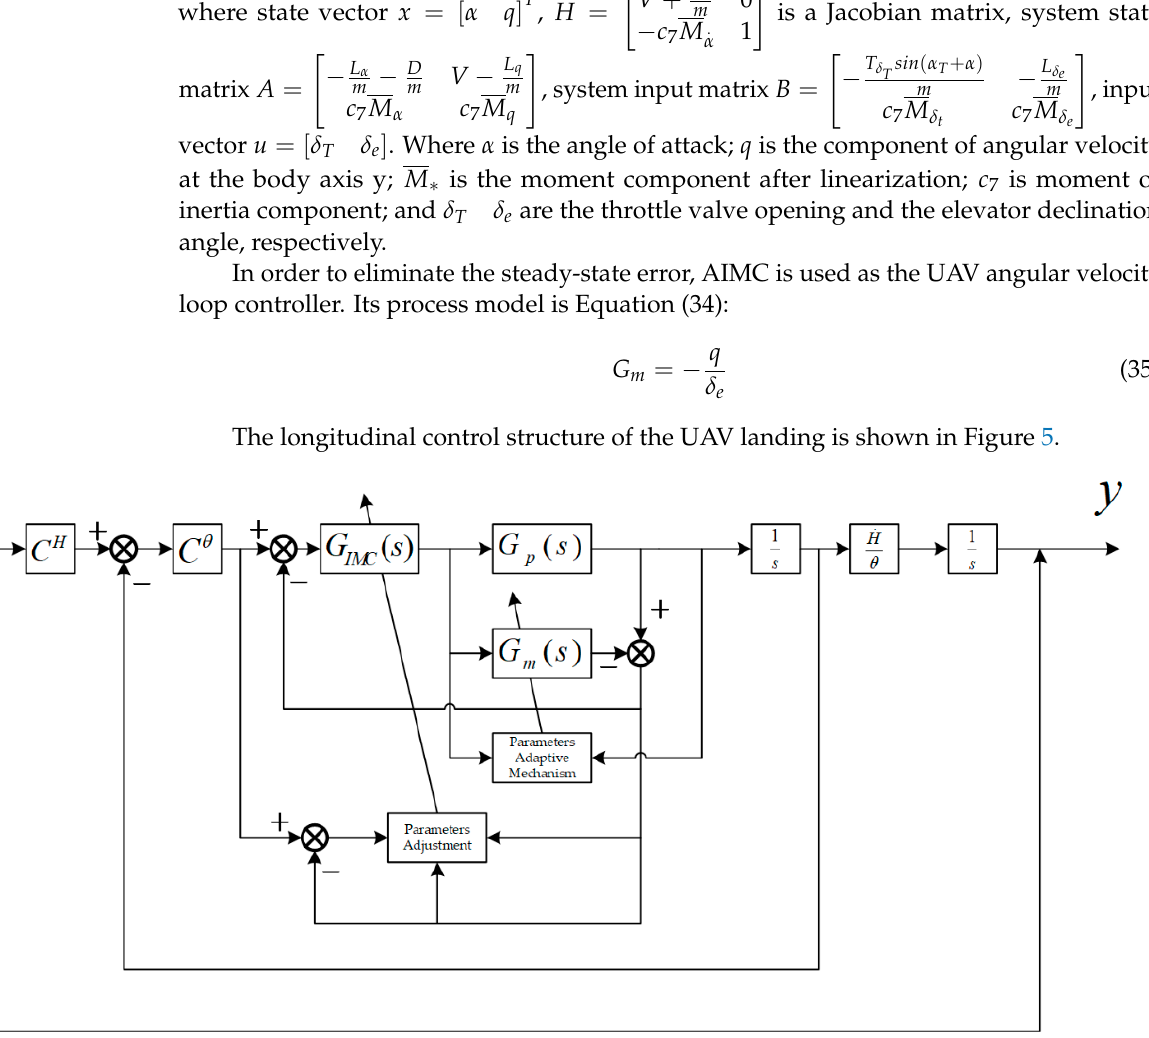
Figure 5. Control structure of longitudinal direction.